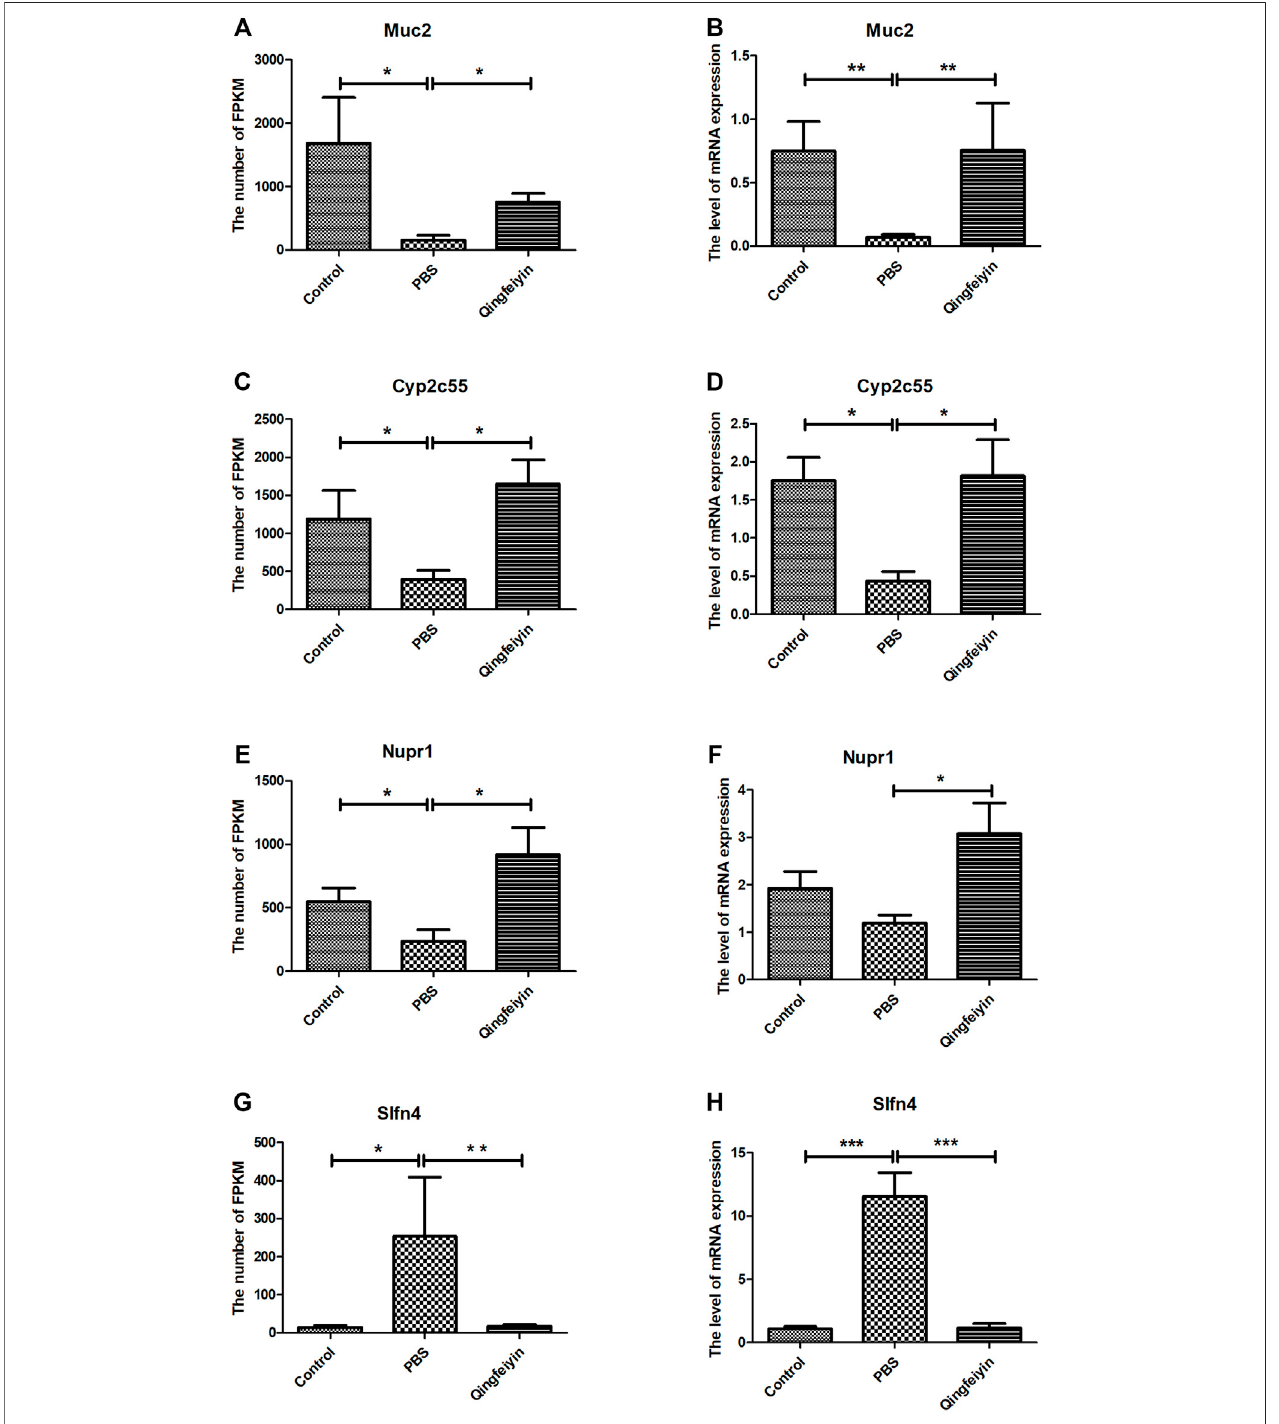
FIGURE 4 | The expression and veri fi cation of the key differential genes. (A,C,E,G) is the expression of Muc2 , Cyp2c55 , Nupr1 , and Slfn4 in three groups by RNA seq, respectively. (B,D,F,H) are the relative abundances of mRNA expression of Muc2 , Cyp2c55 , Nupr1 , and Slfn4 by QRT-PCR. The data were analyzed by ANOVA. p < 0.05 means the signi fi cant differences. * p < 0.05; ** p < 0.01; *** p < 0.001.